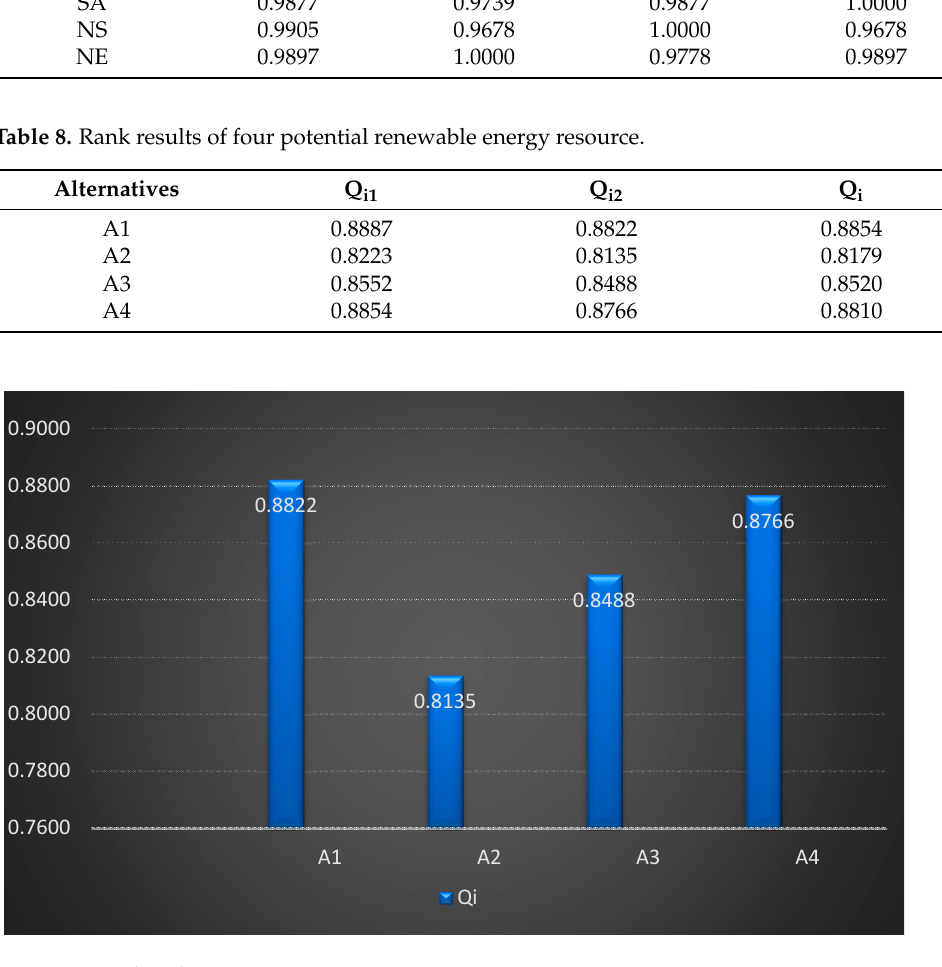
Figure 5. Final ranking.